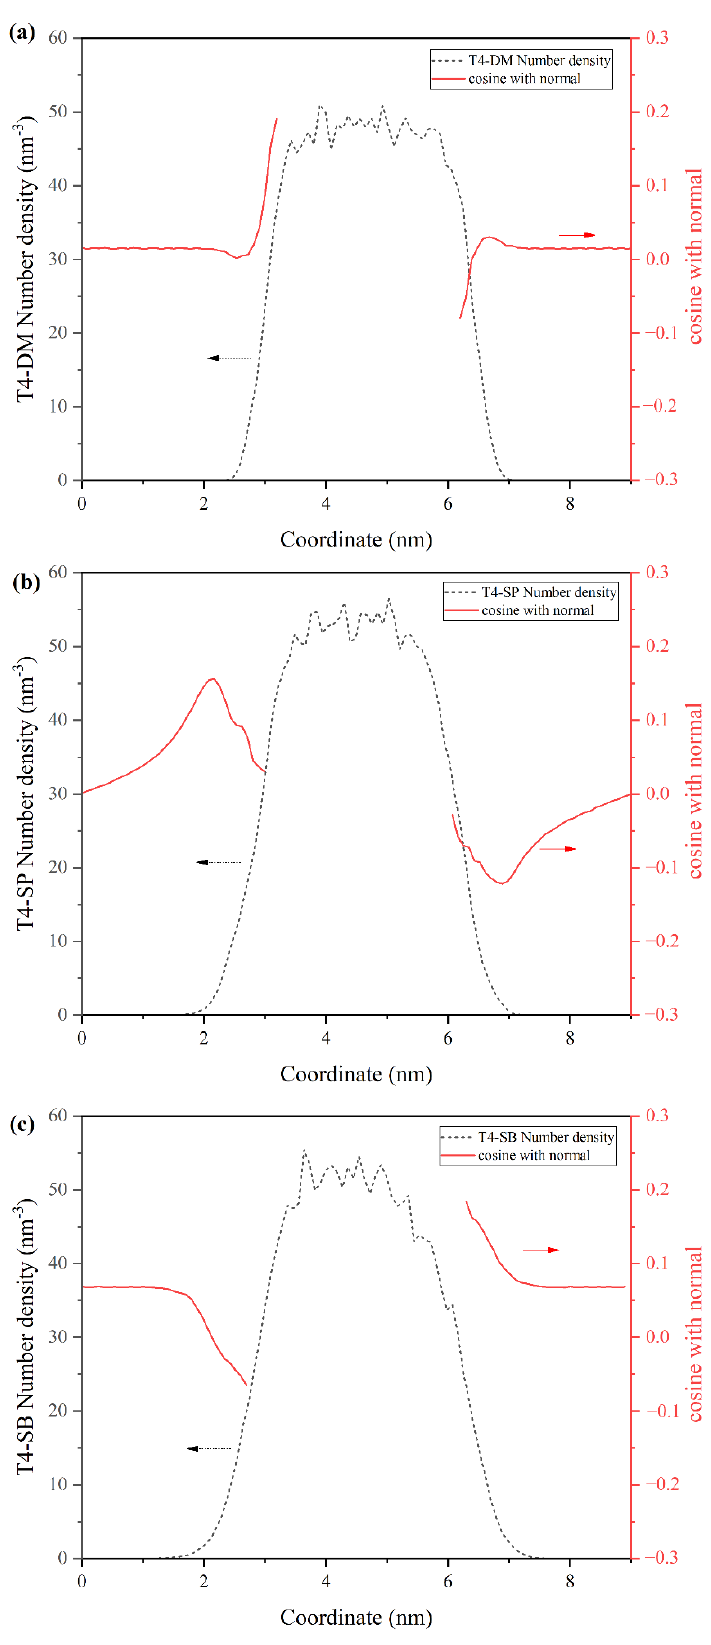
Figure 6. Water dipole orientation profiles of three antifouling membranes. ( a ) T4-DM, ( b ) T4-SP, ( c ) T4-SB.